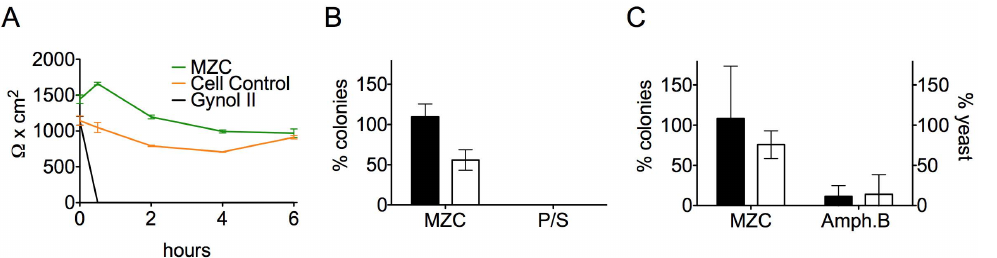
Figure 1. Modified MZC is safe invitro . A) Caco-2 cell monolayer integrity. TEER was measured in differentiated Caco-2 cell monolayers after treatment with 1:10 diluted formulations for 0-6 h. Means 6 SD are shown from two independent experiments performed in triplicate. B) Lactobacilli in vitro viability. MZC toxicity was measured by treating L. jensenii (empty bars) and L. crispatus (filled bars) with 1:10 diluted MZC vs. P/S for 30 min. The number of colonies (mean 6 SD from three independent experiments) relative to saline 7.5% FBS, is shown as a percent. C) C. albicans in vitro viability. MZC toxicity was measured by incubating C. albicans yeasts with 1:10 diluted MZC vs. Amph.B for 2 h. Left axis (filled bars) represents the numbers of colonies counted for each condition and expressed as % colonies relative to the Sabouraud dextrose broth (SB) control (set as 100%). Right axis (empty bars) is the number of viable yeasts counted and shown as the percentage relative to the SB-treated controls. Means 6 SD of 5 independent experiments are